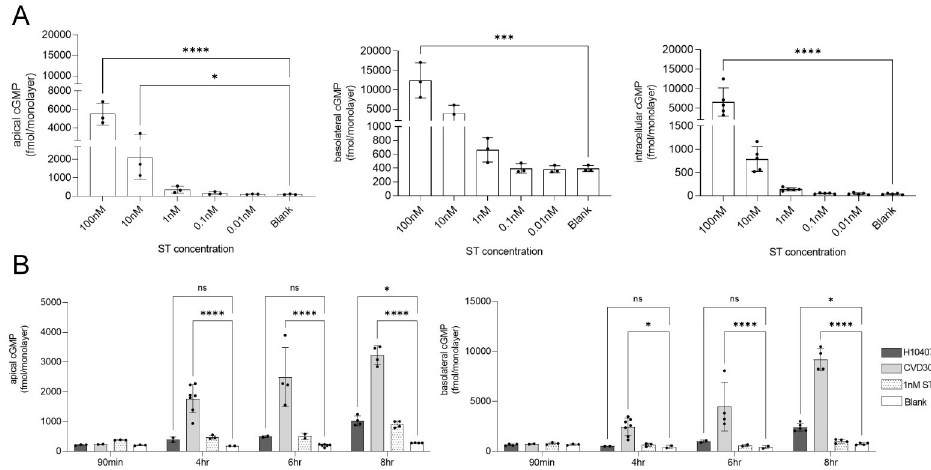
Fig 8. The polarized production of cGMP in human ileal enteroid monolayers following purified ST toxin exposure or infection by wildtype ETEC clinical isolates. Differentiated ileal enteroid monolayers (35I) were exposed to different concentrations of purified ST toxin for 8 hrs (A) or infected with wildtype strains H10407 or CVD30 from 90 min to 8 hrs (B). Apical and basolateral supernatants and intracellular lysates were collected for cGMP ELISA. Data presented are pooled from three independent experiments (A) or eight independent experiments (B). Each dot represents data collected from an individual monolayer. Error bars indicate standard deviations from the means. The asterisks above the bars indicate statistically significant differences determined using one-way ANOVA with Tukey’s multiple-comparison test (A) or two-way ANOVA with Bonferroni’s multiple-comparison test (B). � , p < 0.05; ��� , p < 0.001; ���� , p <